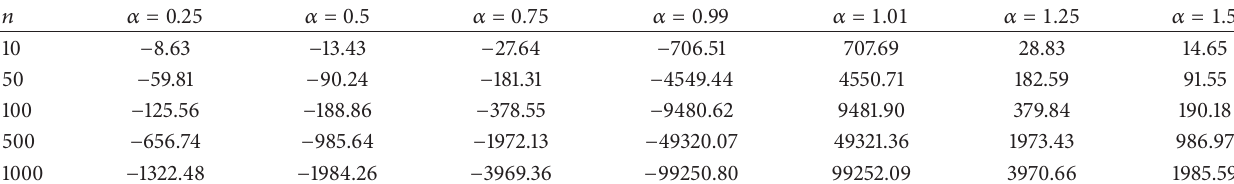
Table 1: Mean of empirical cumulative Tsallis entropy for different values of 𝑛 and 𝛼 .